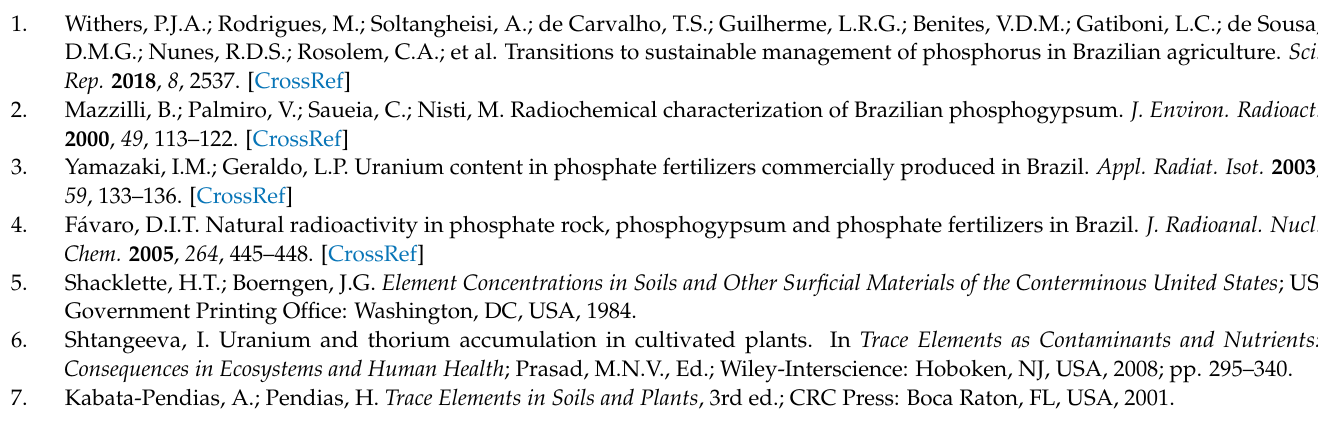
crops studied. Table S2: Activity concentrations, enrichment and bioaccumulation of potassium ( 40 K) in the soils and crops